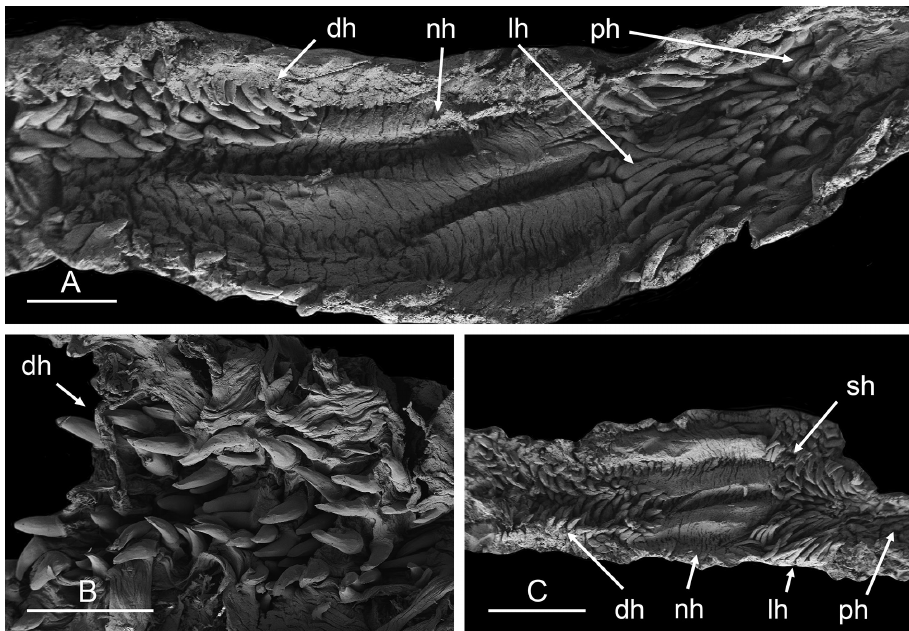
Figure 49. Penis, Wallaconchis graniferum , not evaginated and opened, Philippines, Bohol ( A–B ) [5762] (PNM 041226) ( C ) [5761] (PNM 041228). A Penis invaginated inside the penial sheath opened to reveal regions of penial hooks, scale bar 200 μm B Most proximal region of penis invaginated inside the penial sheath opened to reveal penial hooks, scale bar 200 μm C Penis invaginated inside penial sheath (both opened to reveal the penial hooks), scale bar 0.5 mm. Abbreviations (from proximal to distal): ph proximal hooks (first penial region) lh long slender hooks (second penial region) sh short hooks (sec- ond penial region) nh no hooks (gap) dh distal hooks (third penial